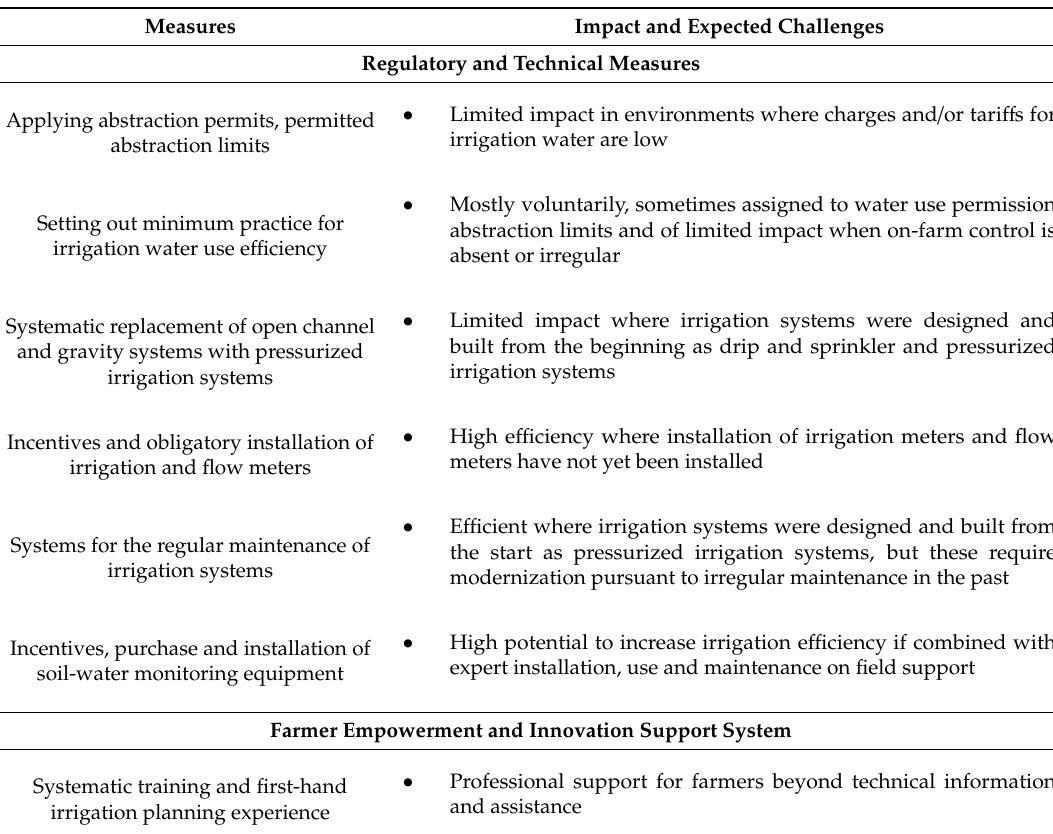
Table 2. Policy options to achieve higher irrigation e ffi ciency and greater agricultural resilience to climate